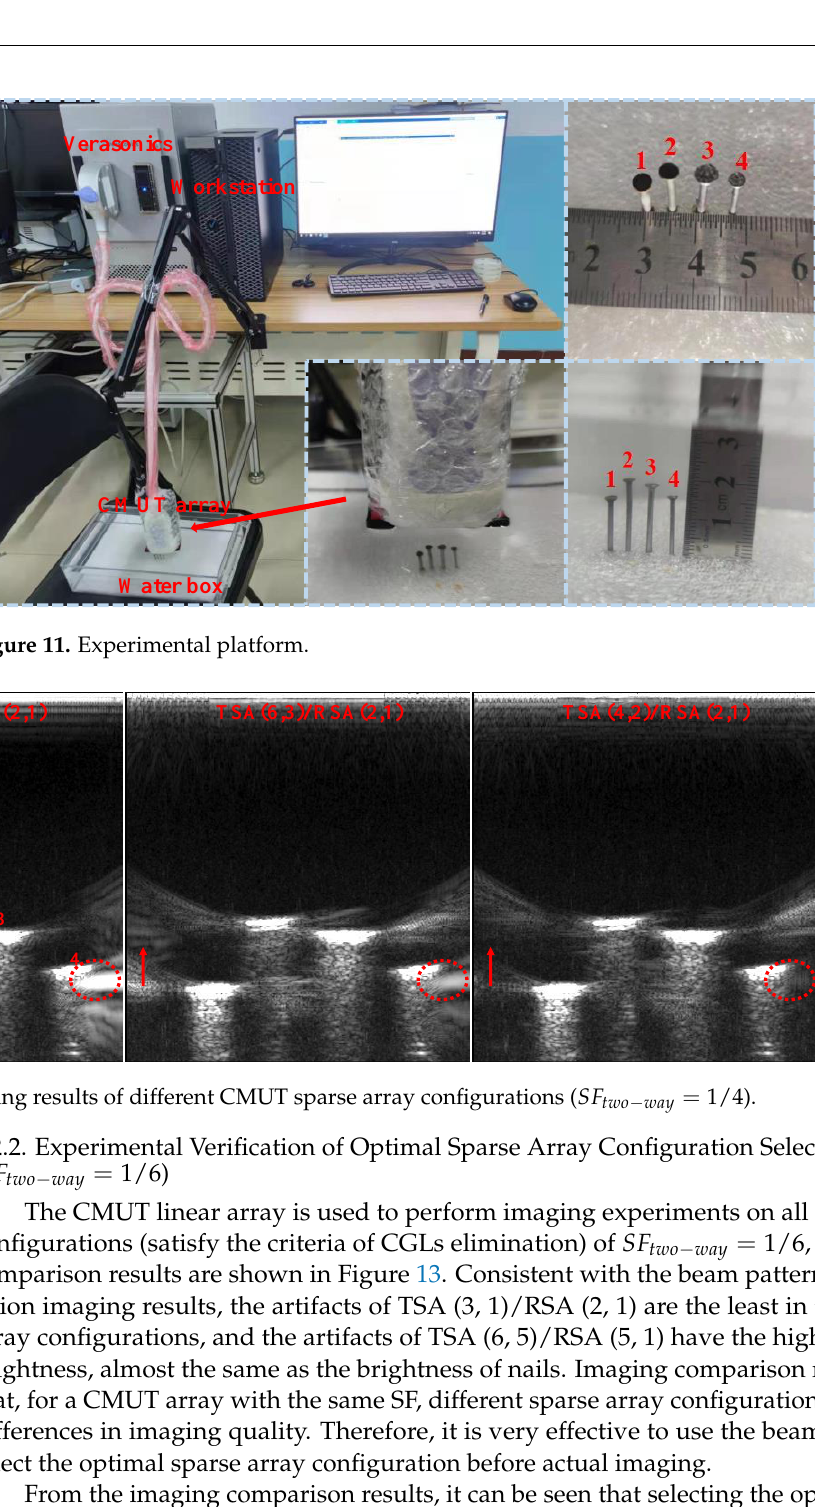
Figure 13. Imaging results of different CMUT sparse array configurations ( =1/ 6 two way SF  ).